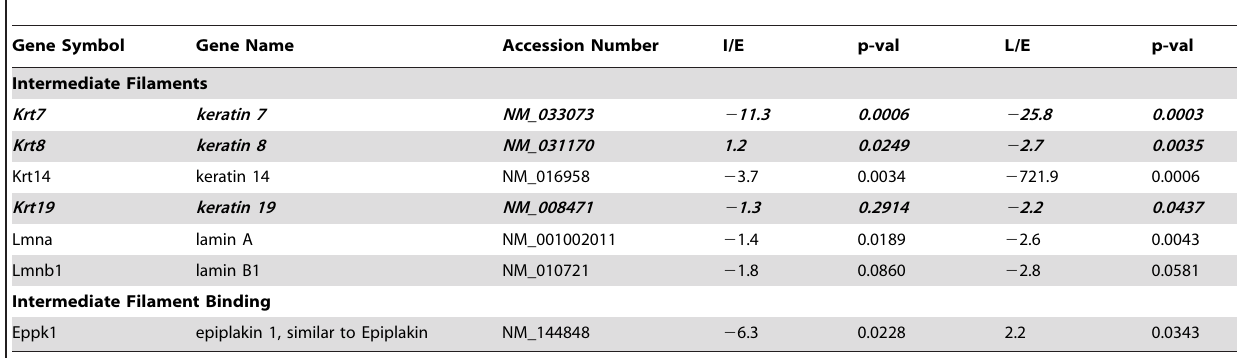
Table 5. Differentially Expressed Intermediate Filaments and Associated Genes in MOSE cell stages.